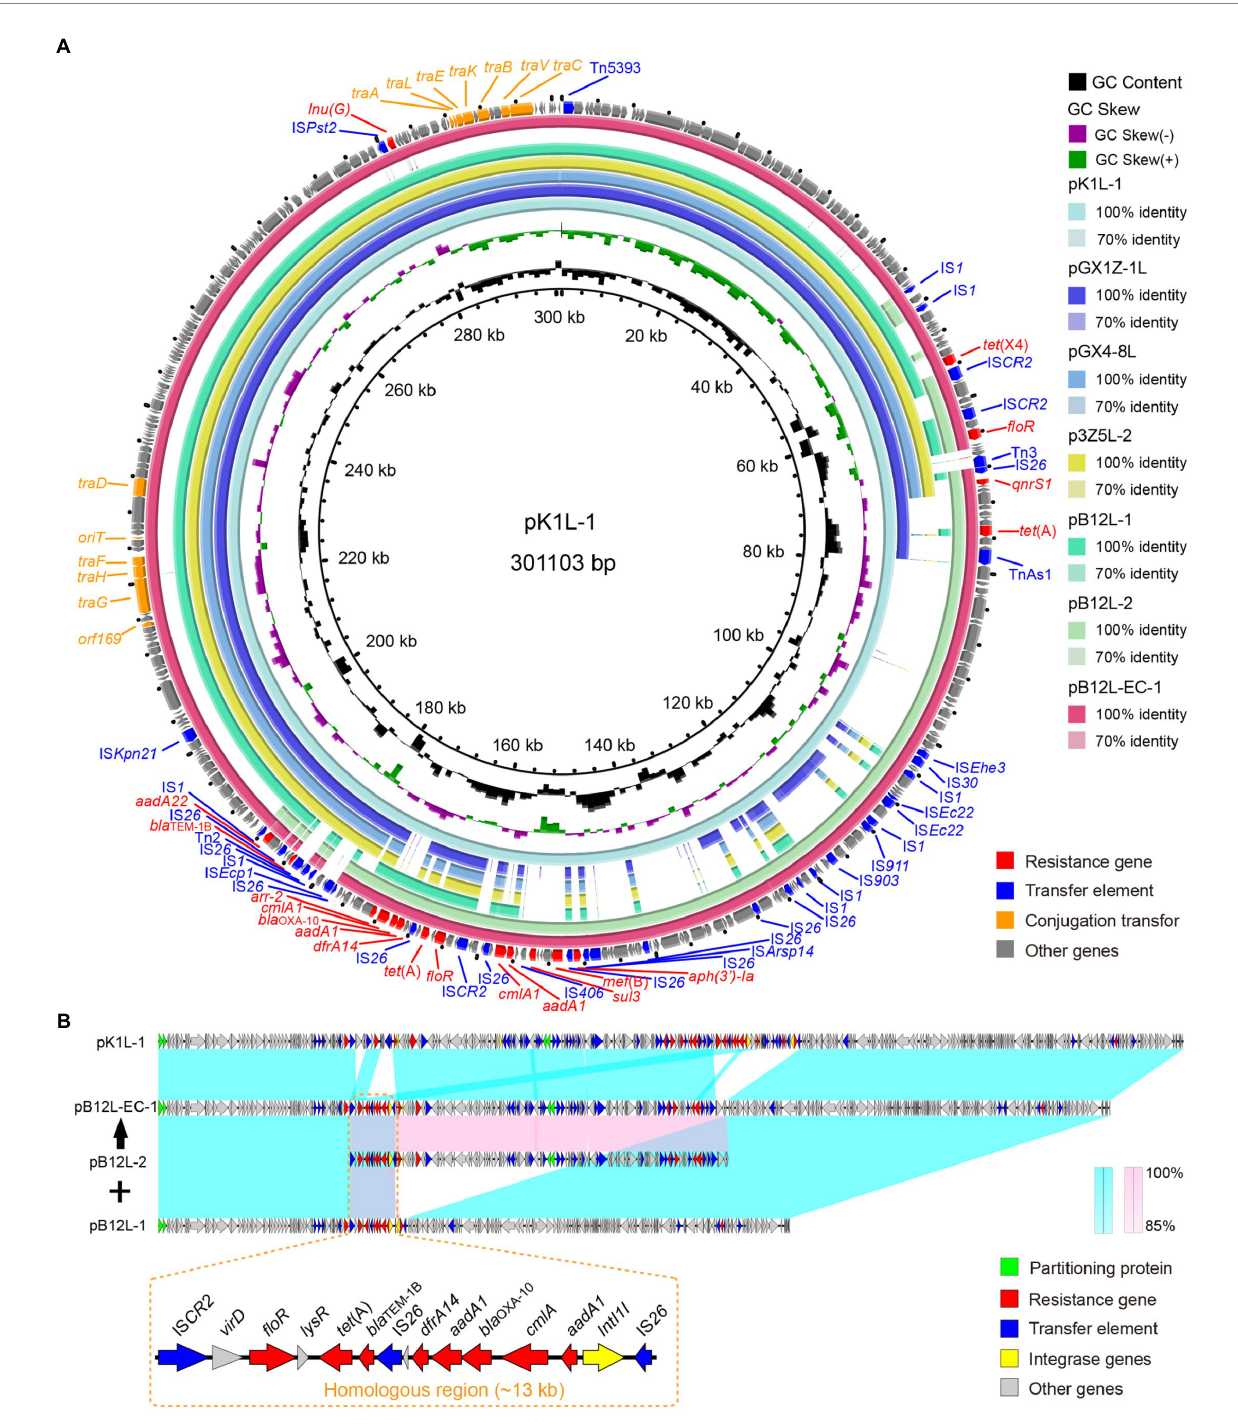
FIGURE 3 Sequence alignment of tet (X) harboring plasmids in this study. (A) The circular genetic map of plasmids pK1L, pGX1Z-1 l, pGX4-8 l, p3Z5L-2, pB12L-1, pB12L-2 and pB12L-EC-1. The pK1L is used as the reference. (B) Linear comparison of plasmids pK1L, pB12L-1 and pB12L-2 with the transconjugant plasmid pB12L-EC-1. The corresponding alignments are represented in wathet blue and pink. The orange dashed boxes indicated the genes in the homologous region. The arrows and triangles represent genes of different function categories (blue: transfer element; red: AMR gene; green: partitioning protein; golden: integrase and resolvase; gray: other